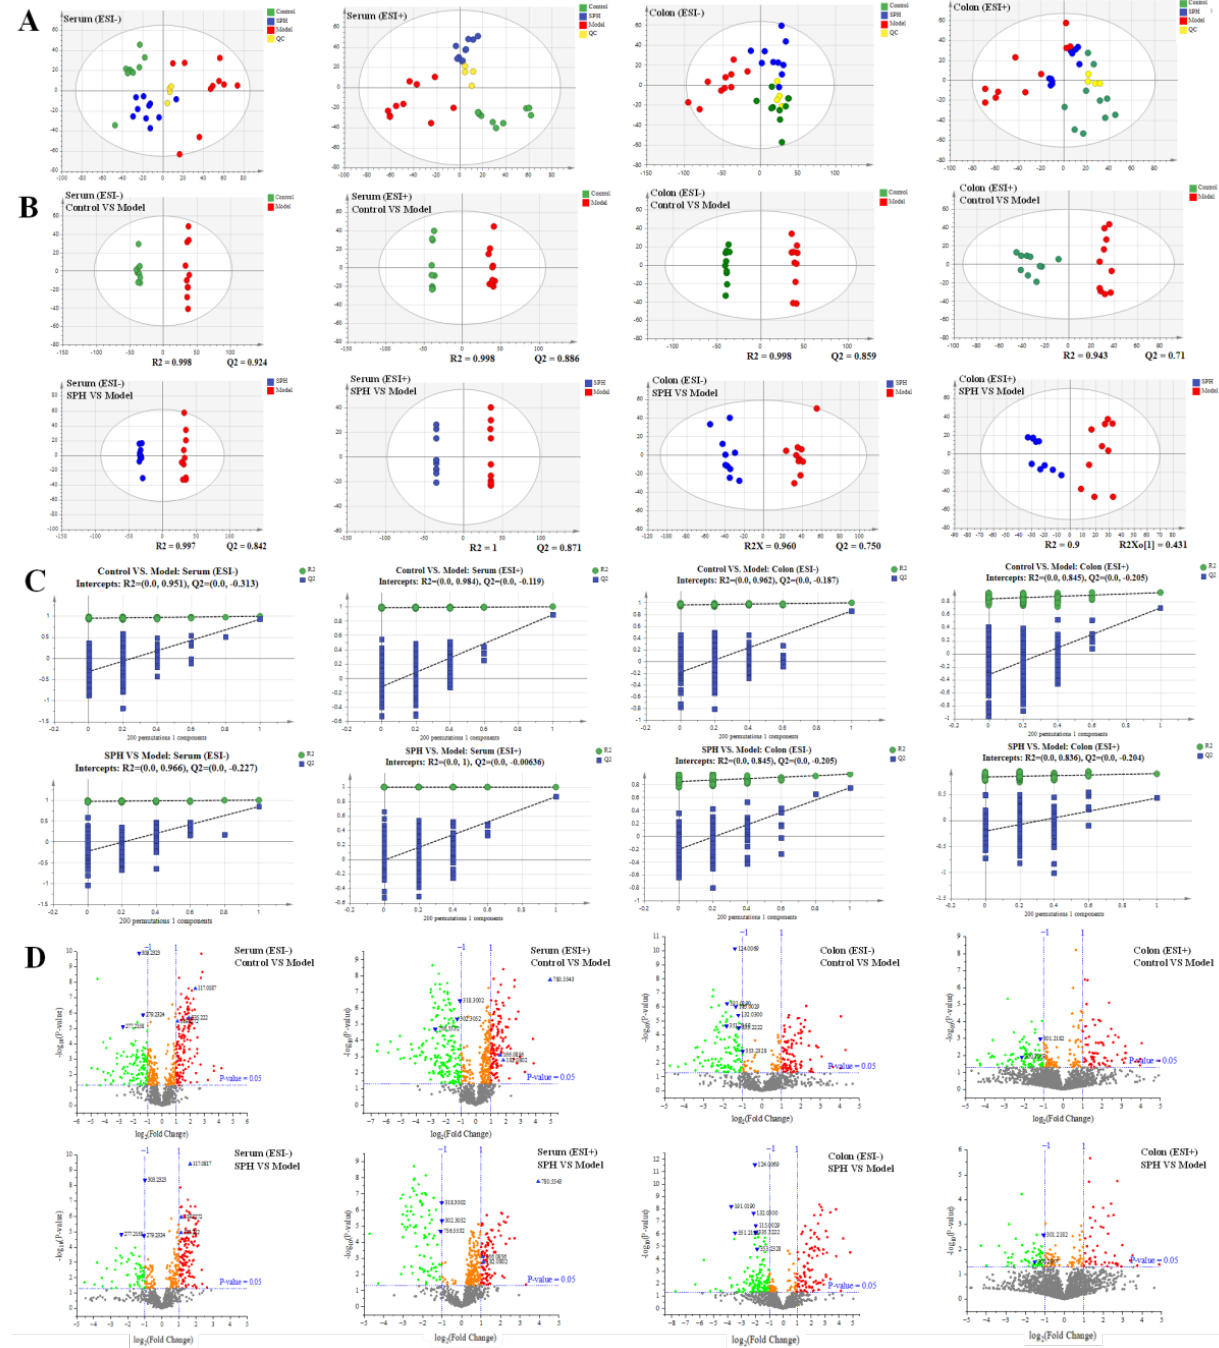
Figure 8. The PCA score ( A ), OPLS-DA score ( B ), permutations test ( C ) and volcano plots ( D ) of serum and colon metabolic